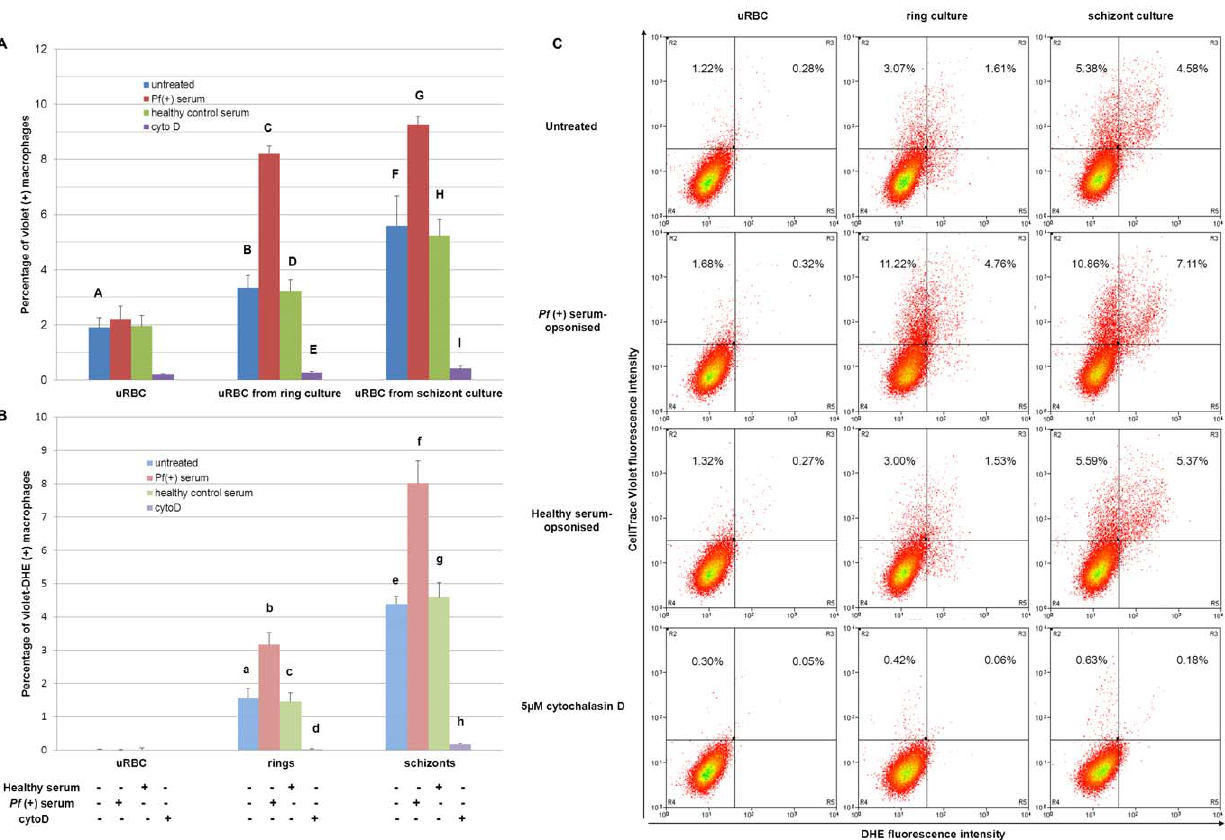
Figure 5. Phagocytosis of fresh uninfected erythrocytes (uRBC), ring-staged (ring culture) and schizont-staged cultures (schizont culture) at 10% parasitemia under different conditions by THP-1 differentiated macrophages. In standard conditions, incubation of erythrocytes with macrophages was carried out for 4 h at 37 u C with an E:T ratio of 1:100. To prevent phagocytosis, macrophages were pretreated with 5 m M cytochalasin D for 1 h before the phagocytic incubation of 4 h at 37 u C. To increase phagocytosis, erythrocytes were opsonised with serum from a Plasmodium falciparum ( + ) patient at room temperature for 30 min before incubation with macrophages. A) Macrophages that have engulfed at least one uRBC and B) macrophages that have engulfed at least one iRBC. Data expressed as mean 6 SEM. (bvc, p , 0.05; BvE, p , 0.005; AvF, CvD, FvI, GvH, evh, fvg, p , 0.001; avd, p=0.098; n=3 separate experiments, each in duplicates) C) Representative dotplots of the respective conditions when exposed to THP-1